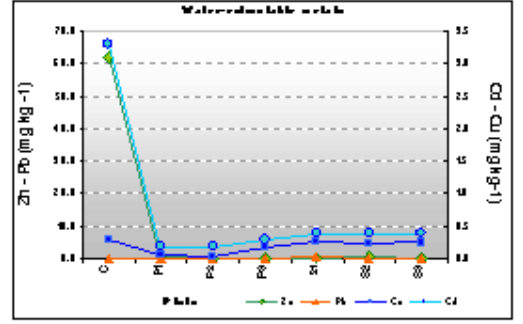
FIGURE 7. Concentration of water-extractable metals found in the plots after 12 months of amendments addition. C: